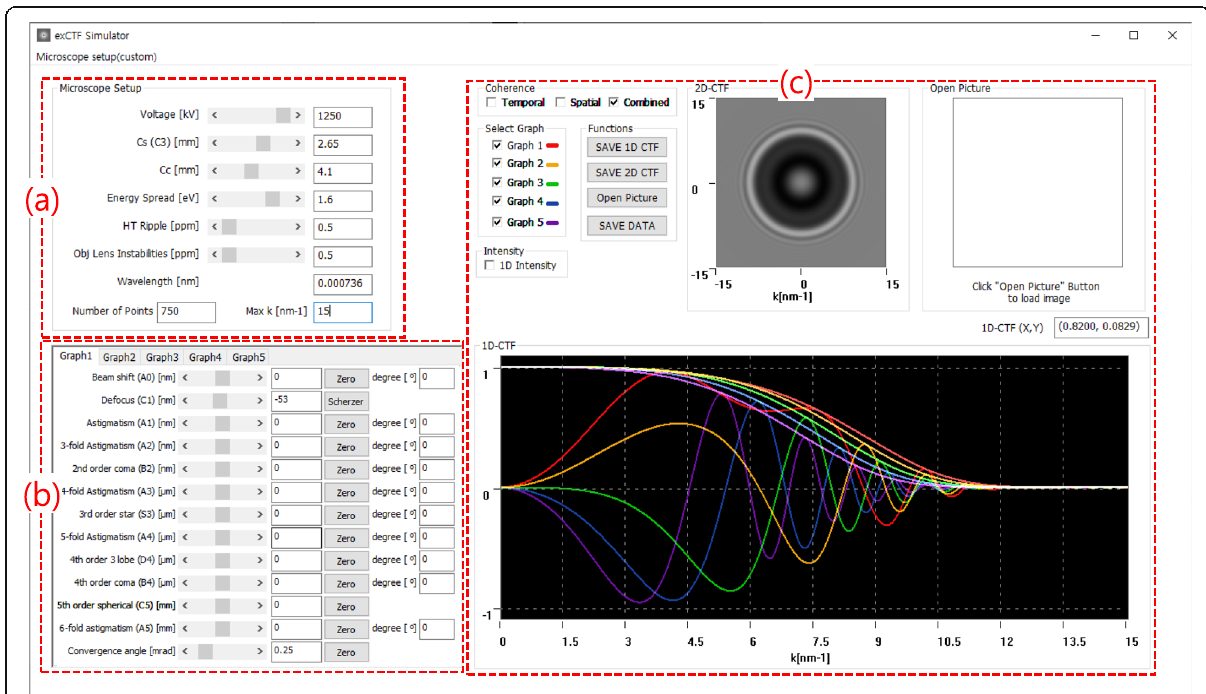
Fig. 1 Interface of the proposed exCTF simulator. The simulator dashboard includes three primary parts for a microscope setup, b optical parameters, and c visualization results, including a 1D-CTF generated by the exCTF